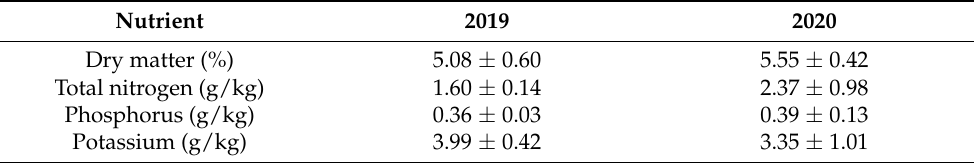
Table 2. Average chemical composition of digestate fresh matter depending on the production year. Nutrient